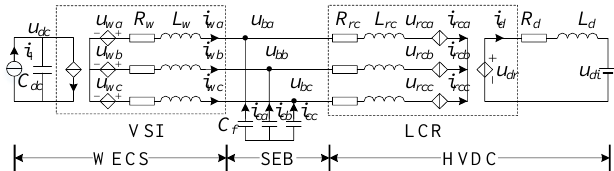
Figure 2. Equivalent circuit, where the wind farm (WF) is represented by a single wind energy conversion systems (WECS) just for a simplified system model. Note that the proposed control scheme is applicable for multiple WECSs (see the next section for more details).